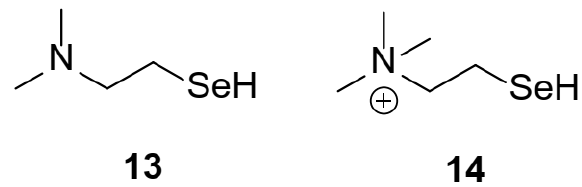
Figure 3. Selenol catalysts studied in this